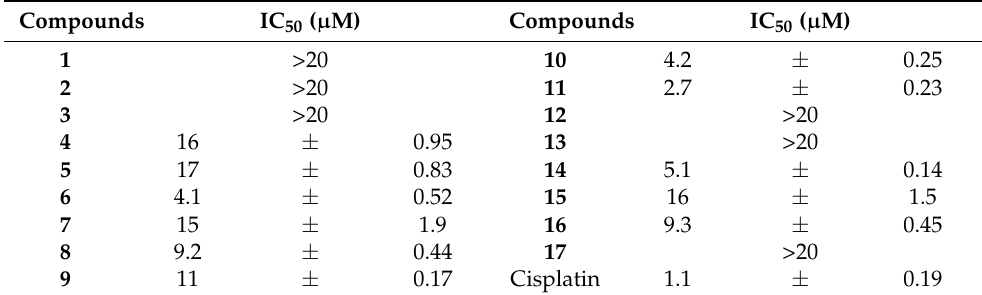
Table 1. Cytotoxic activity of 1 – 17 and cisplatin for HL-60 cells (1) .